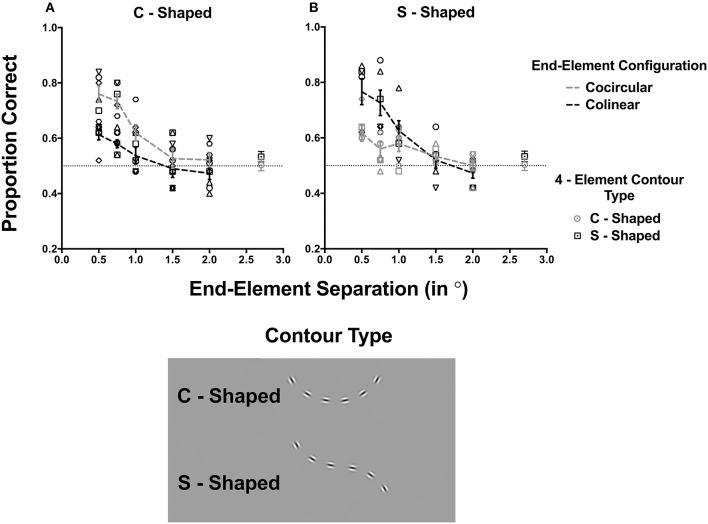
The proportion of times observers correctly identified the contour plotted as a function of the end-element separation and separately for C-shaped and S-shaped contours. Each symbol represents the results for one observer. The conditions in which end elements were collinear and cocircular to the contour are represented by black and gray colored symbols respectively; the observer average for these conditions are given by the dashed lines. Error bars signify 1 standard error of the mean. The dotted horizontal at 0.5 proportion correct represents chance performance.